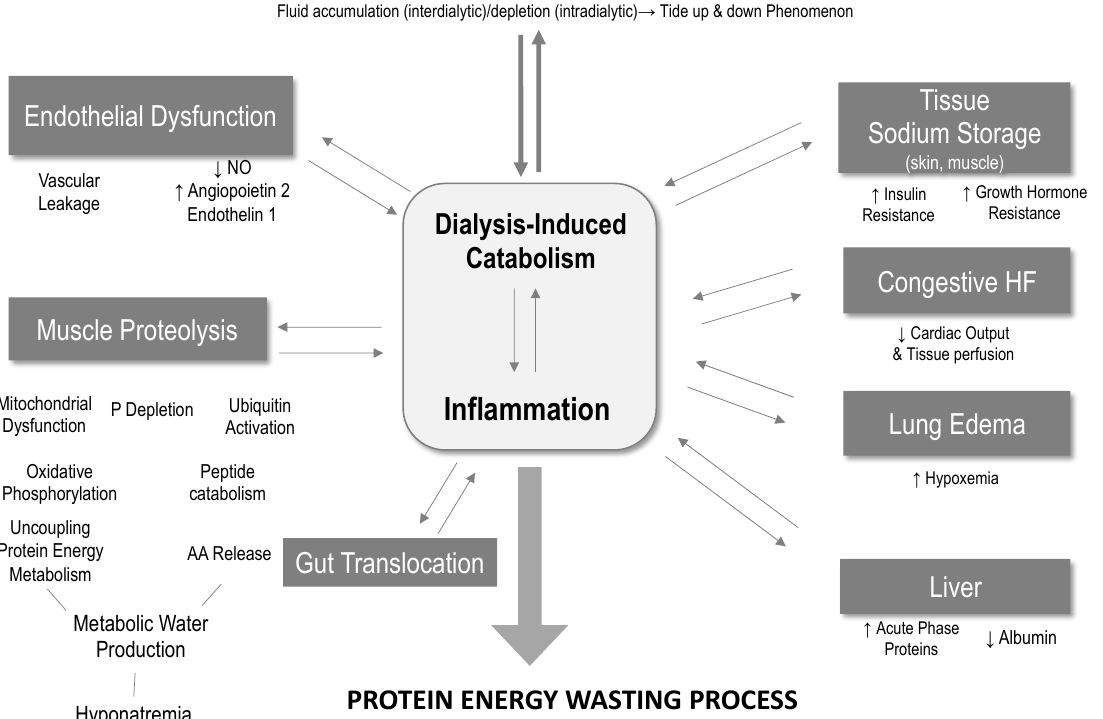
Figure 3. Proposed pathophysiologic link between sodium, fluid volume, and PEM.